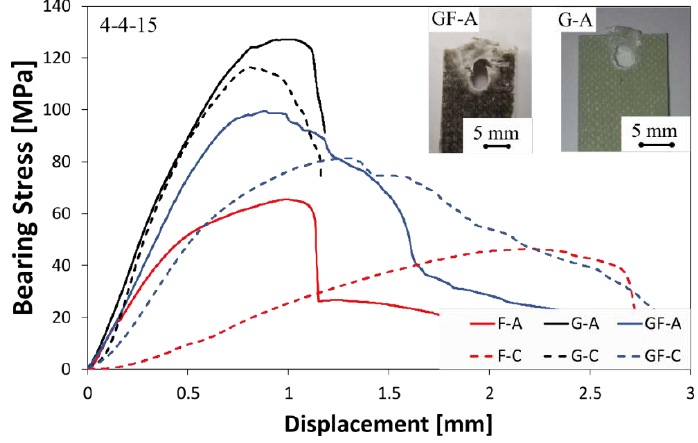
Figure 3. Typical stress – displacement curves of unaged (solid lines) and aged (dotted lines) pinned laminates with D = 4 mm and E = 4 mm.